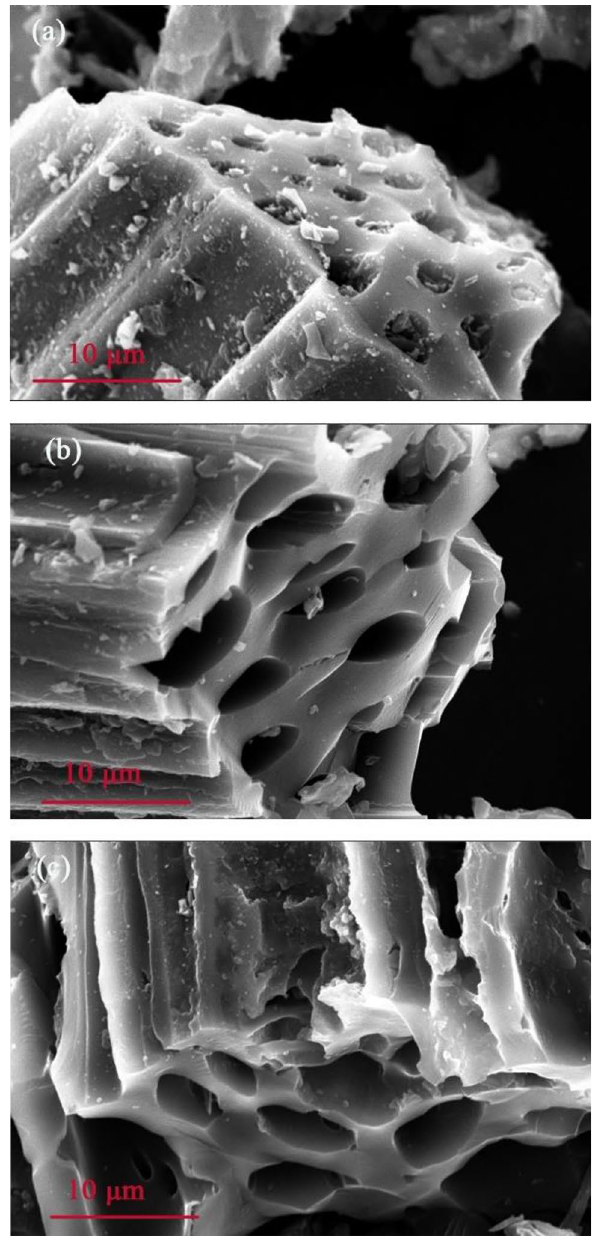
Figure 4. SEM (OPTON) images of C16 biochar and its acid/base modification: ( a ) C16, ( b ) C16-H, and ( c )